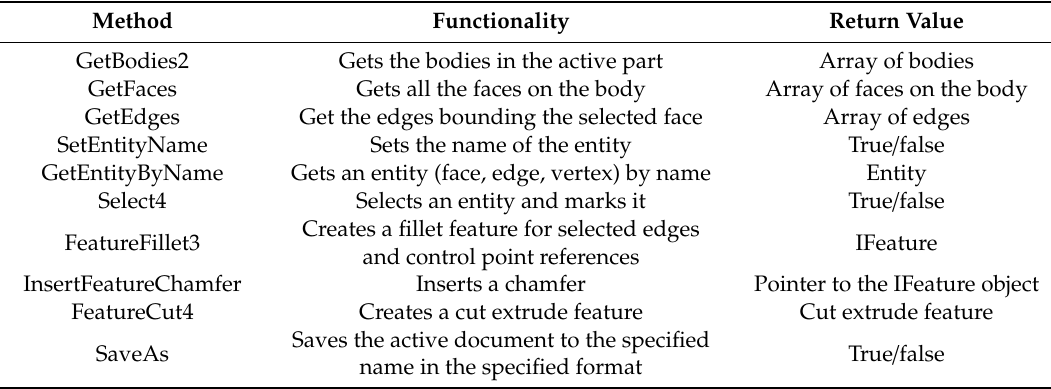
Table 2. API methods used for the topology